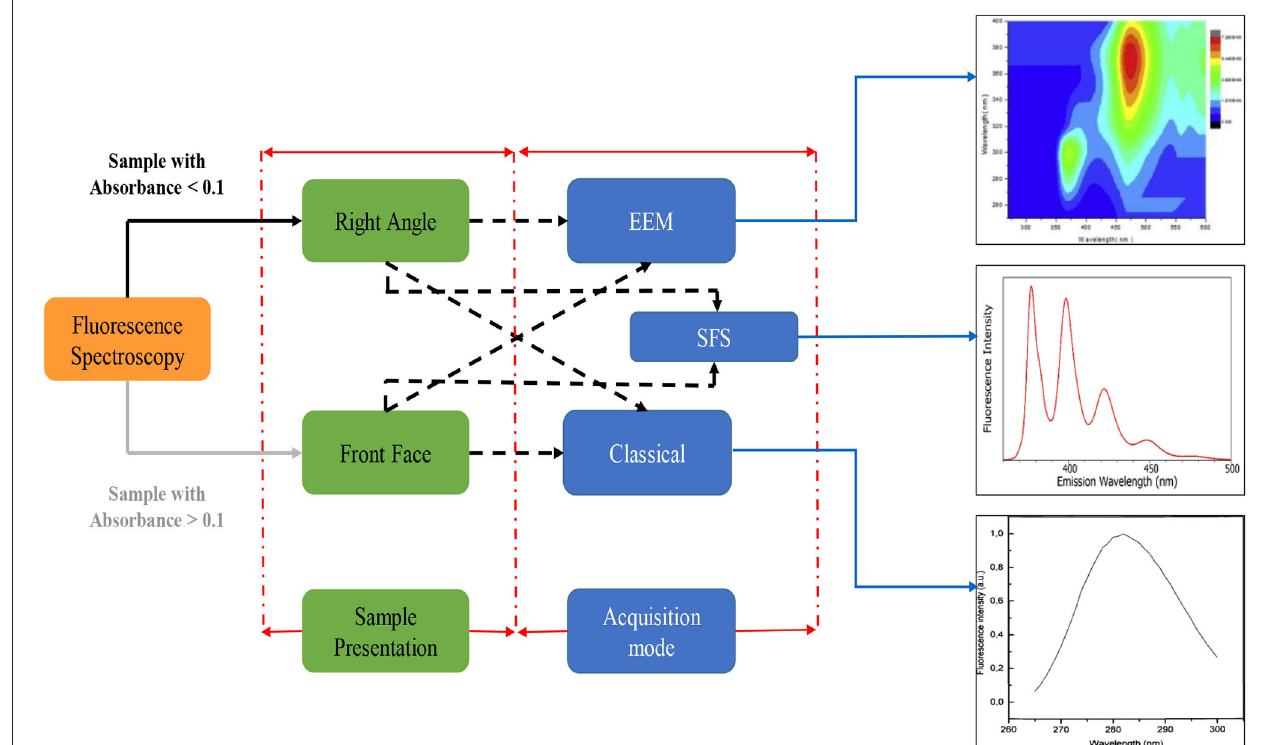
FIGURE 2 | Fluorescence spectroscopy principal acquisition mode; EEM, Excitation emission matrix; SFS, Synchronous fluorescence spectroscopy.